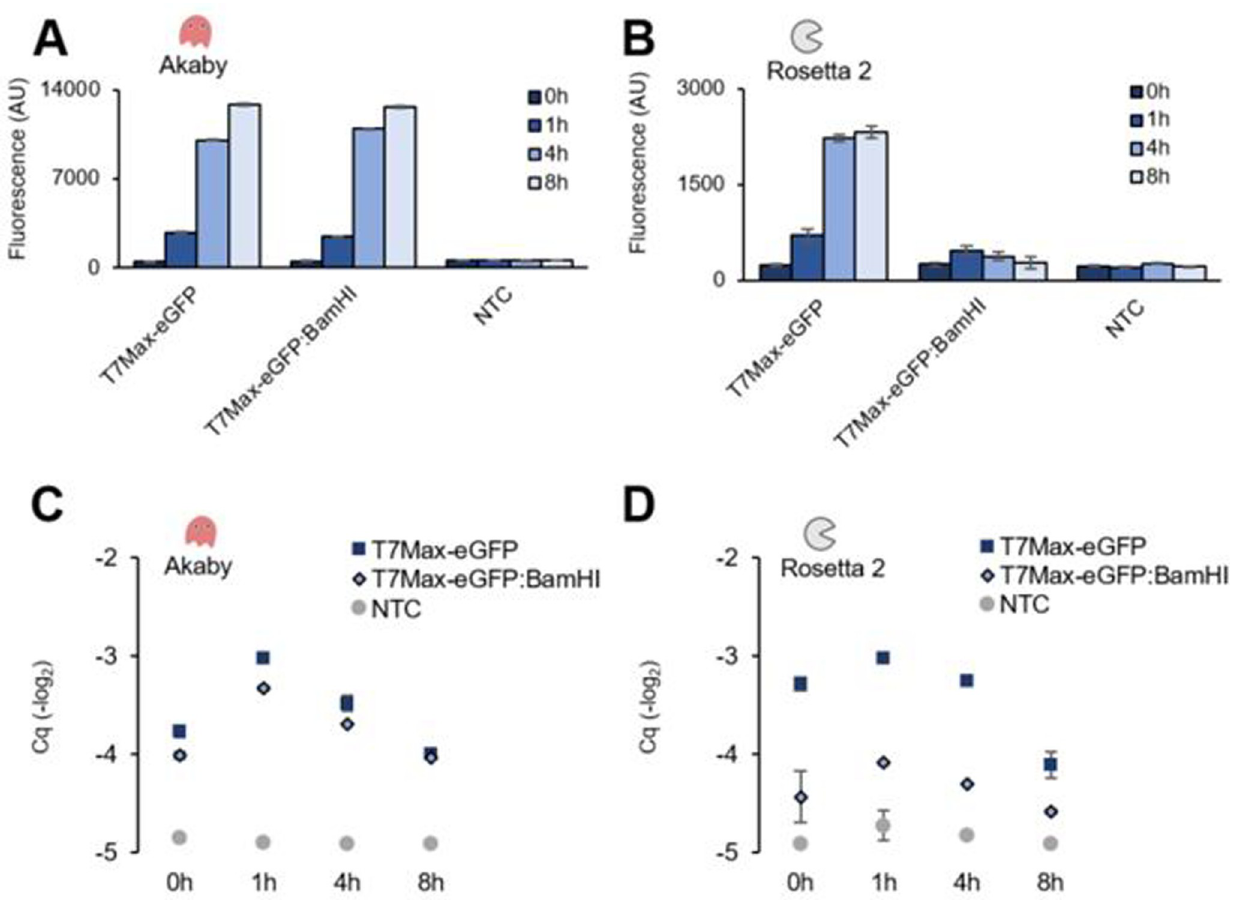
Fig 3. eGFP expression and mRNA abundance in Akaby and Rosetta 2 TXTL at 0, 1, 4, and 8 hours incubation. TXTL reactions were performed with eGFP templates (5 nM) at 30˚C and the fluorescence and mRNA abundance were measured at 0, 1, 4, and 8 hours. The fluorescence was measured at λ ex 488 nm and λ em 509 nm. Fluorescence generated (A) in Akaby TXTL and (B) in Rosetta 2 TXTL. RT-qPCR was performed with a primer pair targeting the eGFP gene. Cq values of mRNA transcribed (C) in Akaby TXTL and (D) in Rosetta 2 TXTL. T7Max, the enhanced T7 RNA polymerase promoter; template named with BamHI, linearized plasmids by BamHI; NTC, no template control; Cq, quantitation cycle. The graphs show means with error bars that signify SEM (n =